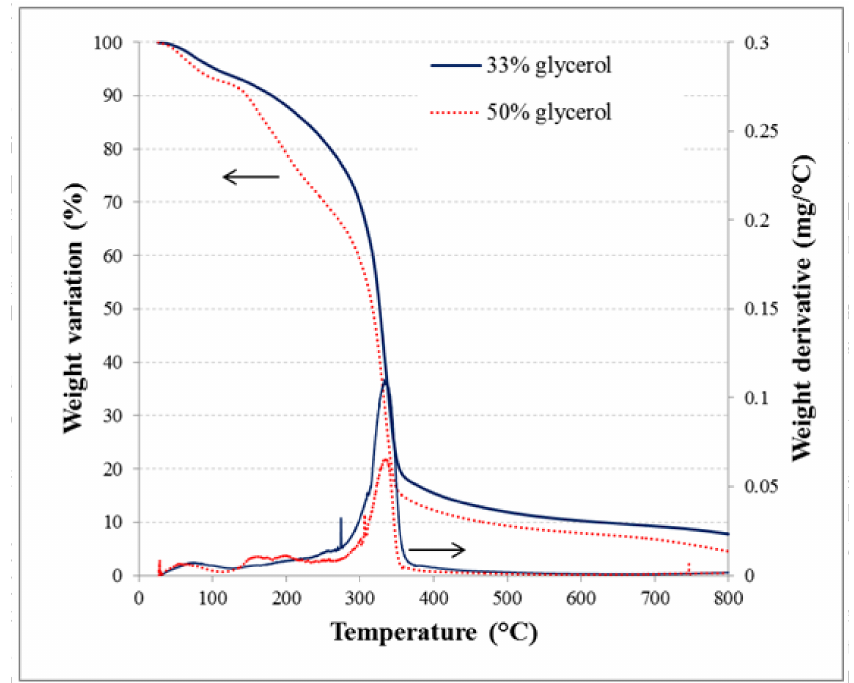
Figure 4. Weight loss vs. temperature (and its derivative) of films containing either 33% or 50% of glycerol equilibrated at 53% relative humidity (RH) prior thermogravimetry